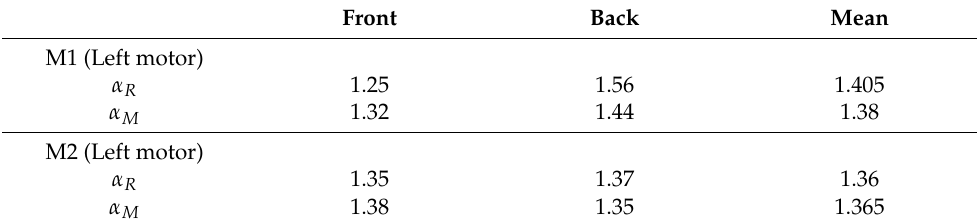
Table 2. Friction constants as measured through different